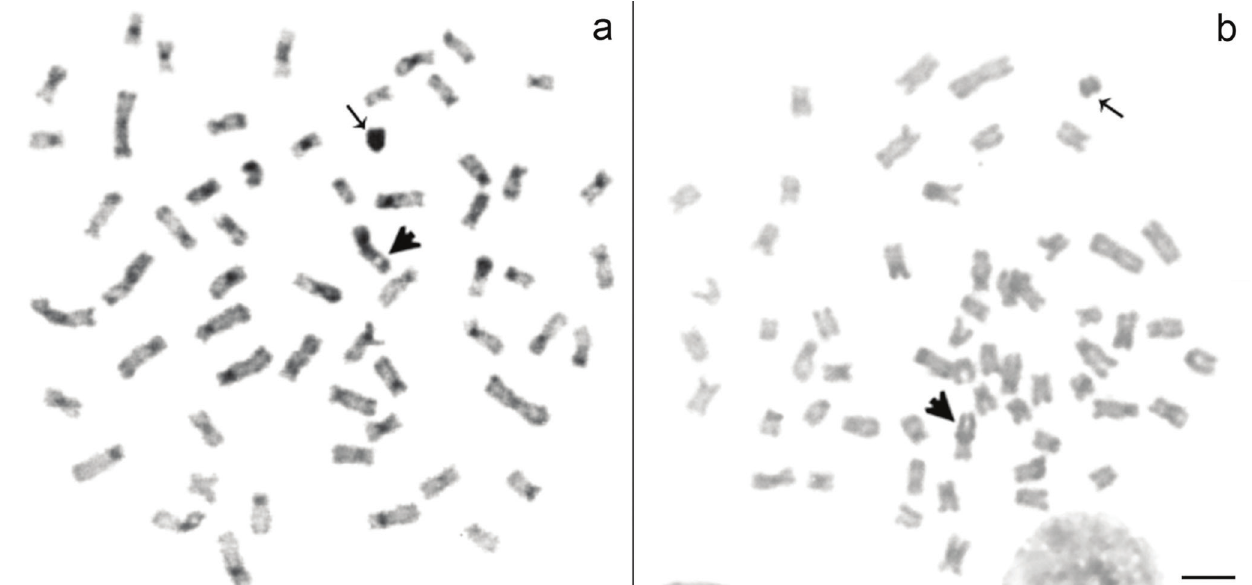
Fig. 2. C-banded metaphases of Callichthys callichthys : the arrowhead indicates the third NORs bearing chromosome and the arrow indicates the (a) acrocentric B chromosome and the (b) ill-defined acrocentric B chromosome. The bar represents